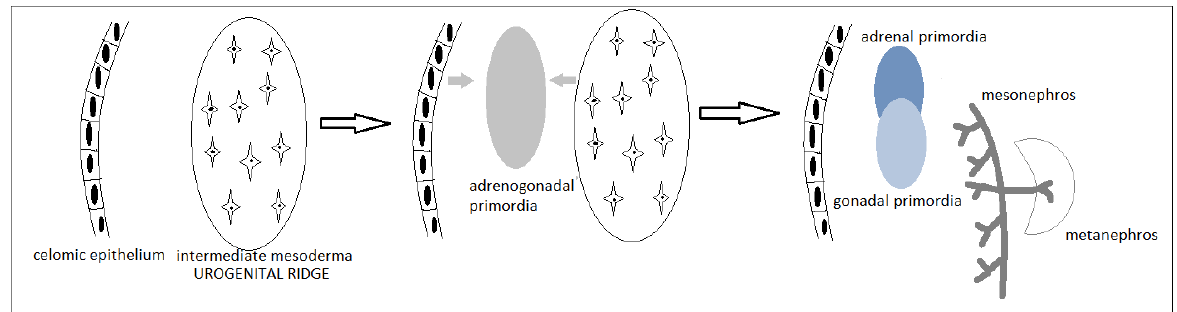
Figure 2. Development of gonadal, adrenal and renourinary primordia in week 4 (first two stages in figure)—week 5 (third stage) [14].